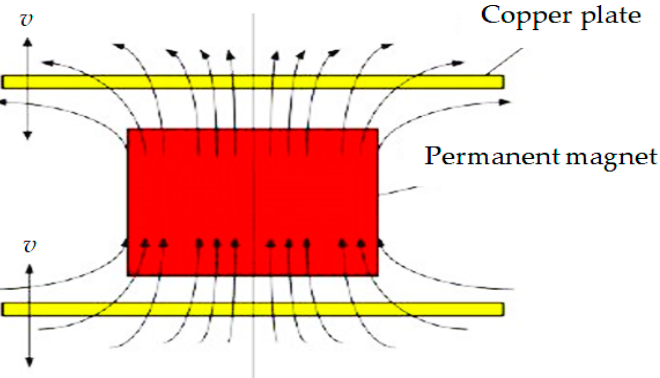
Figure 6. Schematic diagram of electromagnetic damping [46]. (Reprinted from ref. [46].